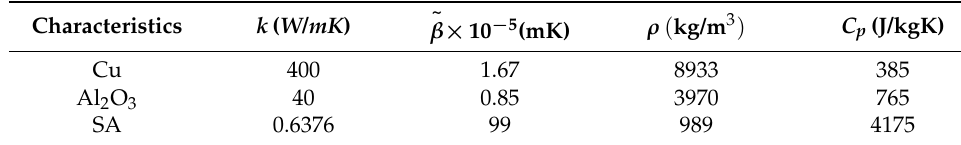
Table 1. The characteristic properties [35,36].